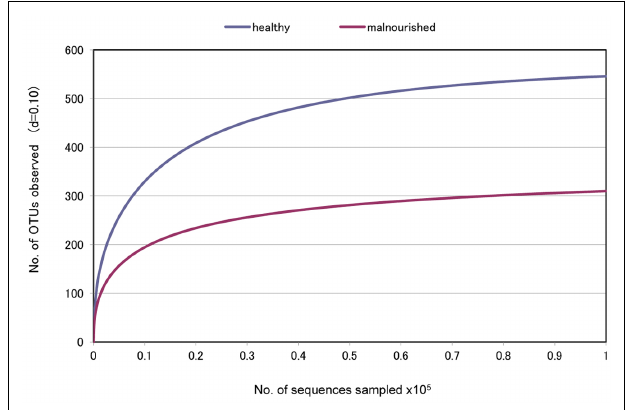
FIGURE 1 | “Rarefaction Curve” showing differences in the divergence between the gut microbiota of healthy and malnourished children. d , distance cut off